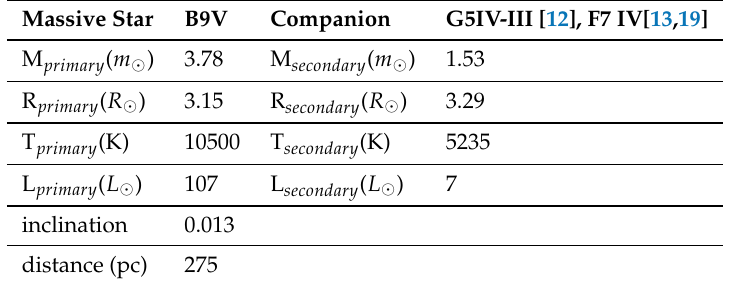
Table 1. Fundamental parameters for TV Cassiopeia (TV Cas, see Erdem [12] and Khalesseh & Hill